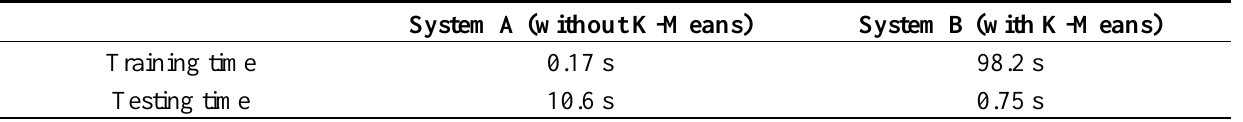
Table 4. Training and testing times of Systems A and